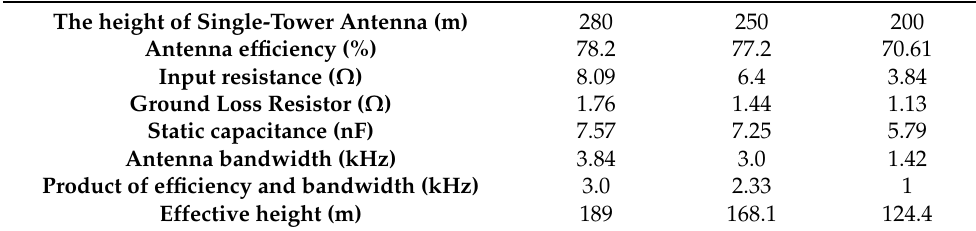
Table 1. Main Performance Parameters of the Single-Tower Antenna. The height of Single-Tower Antenna